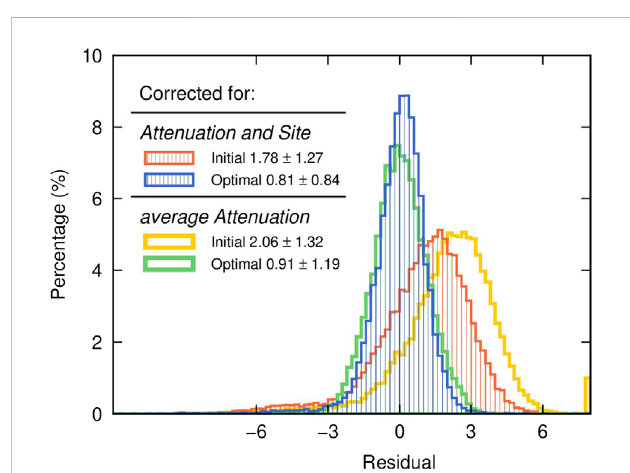
FIGURE 4 Histogram comparing the amplitude residuals. Red and blue histograms represent the distributions of residuals between the observed and predicted Lg spectra before and after inversion based on bothattenuationandsitecorrections.Yellowandgreenhistograms represent the distributions of residuals between the observed and predicted Lg spectra before and after inversion based on constant attenuation.Theinitialand fi nalrmsresidualanddeviationarelabeledfor both inversion